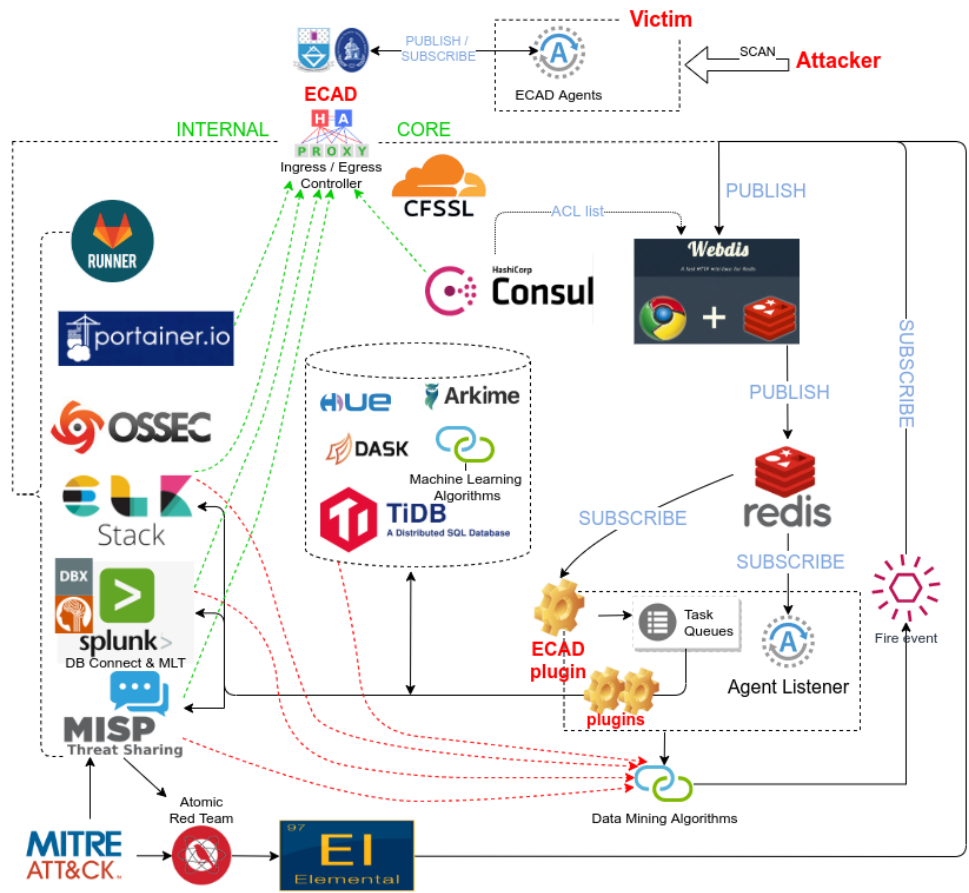
Figure 4. Sample technologies used to implement the ECAD framework and a sample data